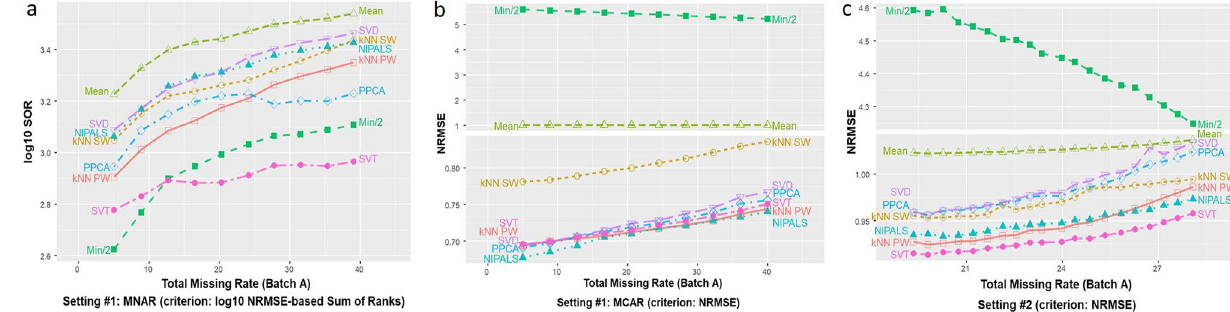
Figure 3. ( a ) Imputation performance of the eight methods on the simulation data of setting #1, with assumed MNAR missing mechanism and varying total missing rates. ( b ) Imputation performance of the eight methods on the simulation data of setting #1, with assumed MCAR missing mechanism and varying total missing rates. ( c ) Imputation performance of the eight methods on the simulation data of setting #2, focusing on authentic missing mechanism and varying masked rates.